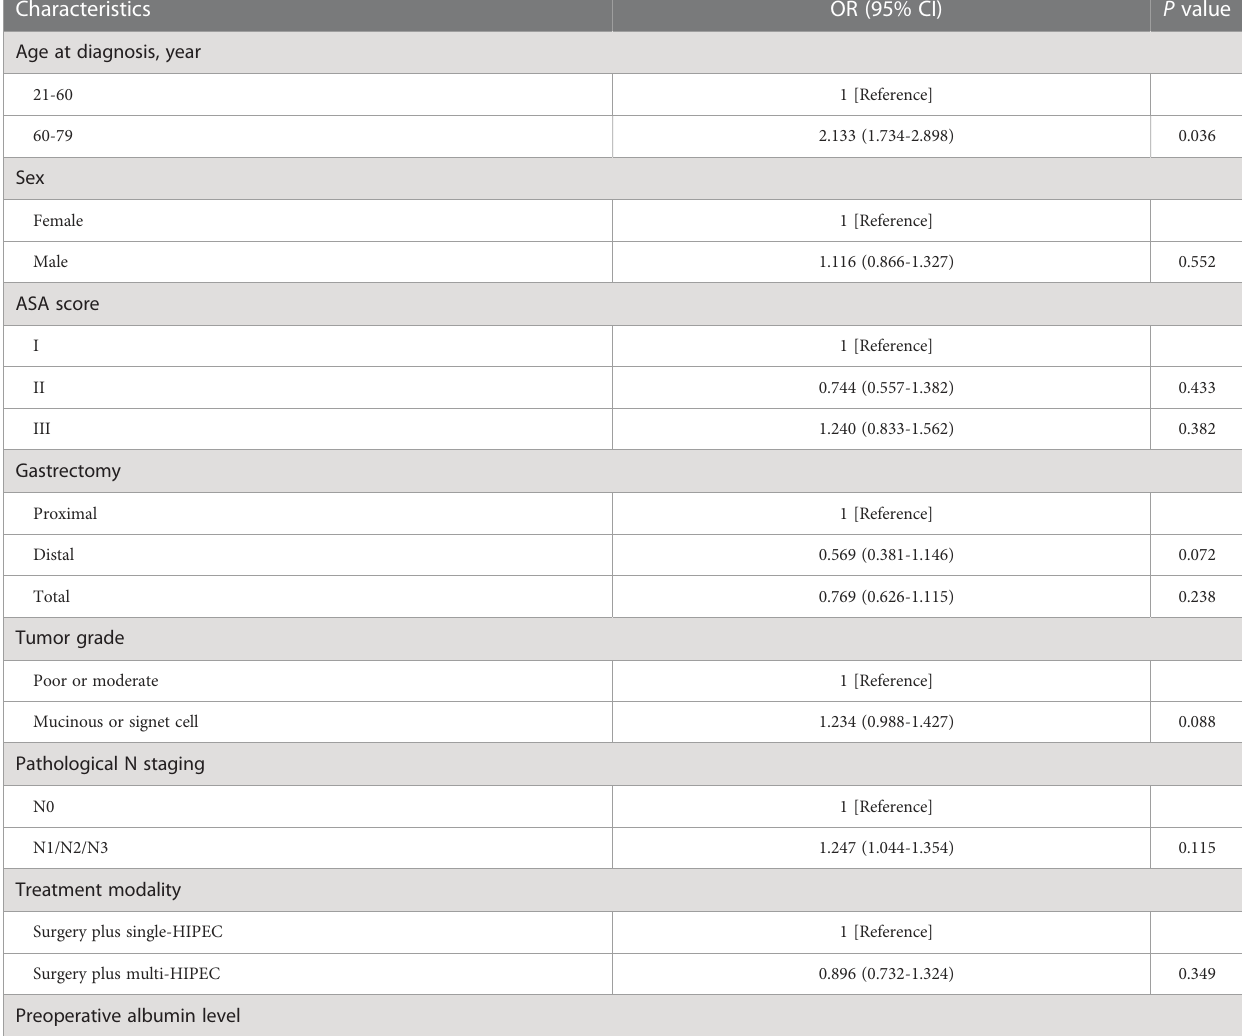
TABLE 3 Multivariable analysis of factors in fl uencing postoperative complications.